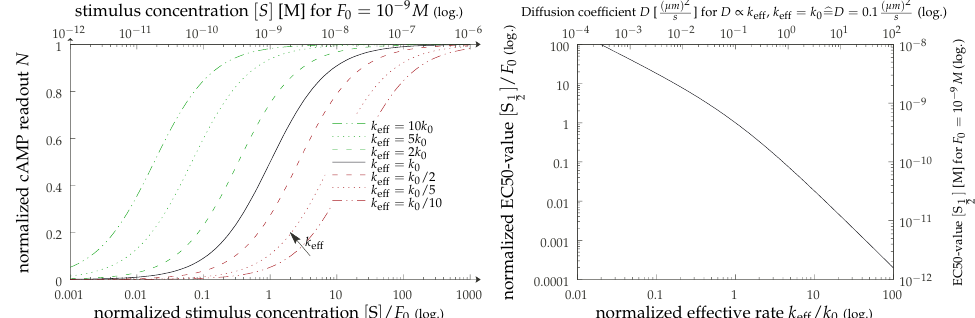
normalized stimulus concentration [ S ] / F 0 (log.) Figure 6. ( Left ) Visualization of the results from Equation (9). We show artificial dose–response curves for various values of the effective rate k eff which, in the diffusion-limited regime, corresponds to the relative diffusion constant. In the upper x -axis, we provide a possible instance of physical values for a typical value of F 0 . ( Right ) The EC 50 values (i.e., the stimulus concentrations for which the response is half maximal as a function of the dynamically controlled effective rate (lower x -axis) or the diffusion constant (using typical values; upper x -axis)).